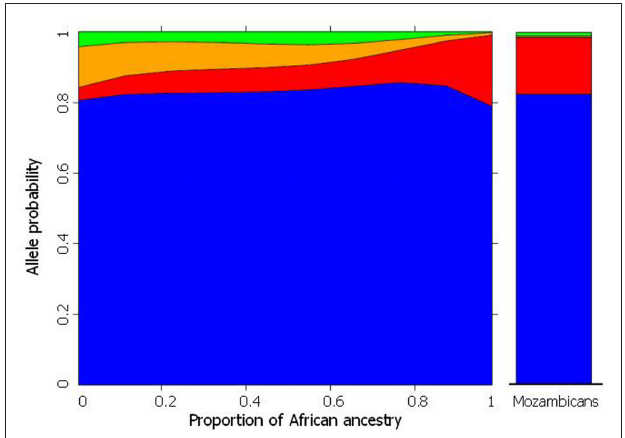
FIgure 2 | The plot on the left shows the frequency distribution of CYP2C8*1 (default, blue) *2 (red) , *3 (orange), and *4 (red) alleles according to the estimated individual proportion of African ancestry in 958 healthy, unrelated Brazilians. Non-linear logistic regression was applied to describe the association between biogeographical ancestry and frequency of CYP2C8 alleles. Data from Suarez-Kurtz et al. (2010b). The plot on the right shows the frequency of the CYP2C8 alleles in 70 healthy, unrelated Mozambicans (Suarez-Kurtz and Damasceno,